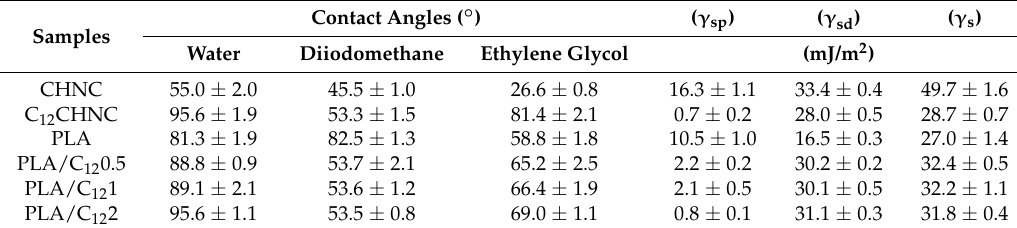
Table 3. Contact angle and surface energy components (polar γ sp , dispersive γ sd and total γ s ) values of the samples.